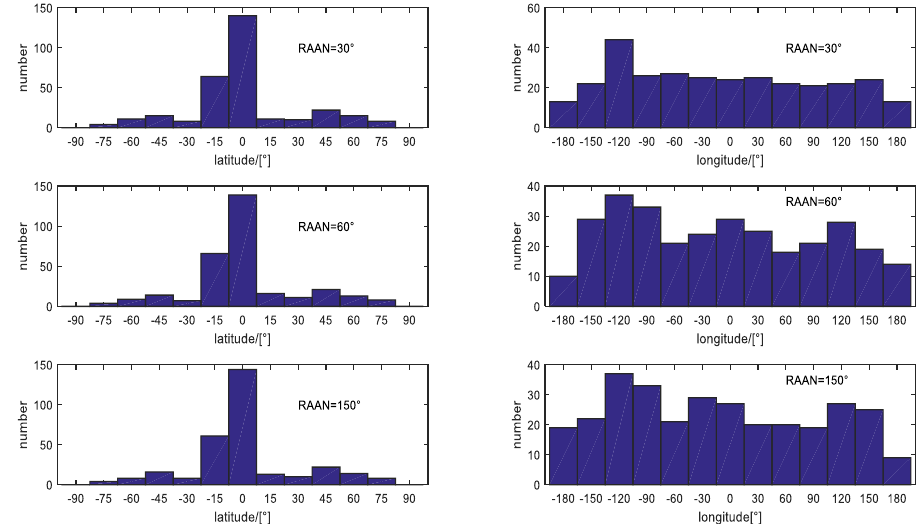
Figure 9. Changes in latitudinal and longitudinal coverage with RAAN .